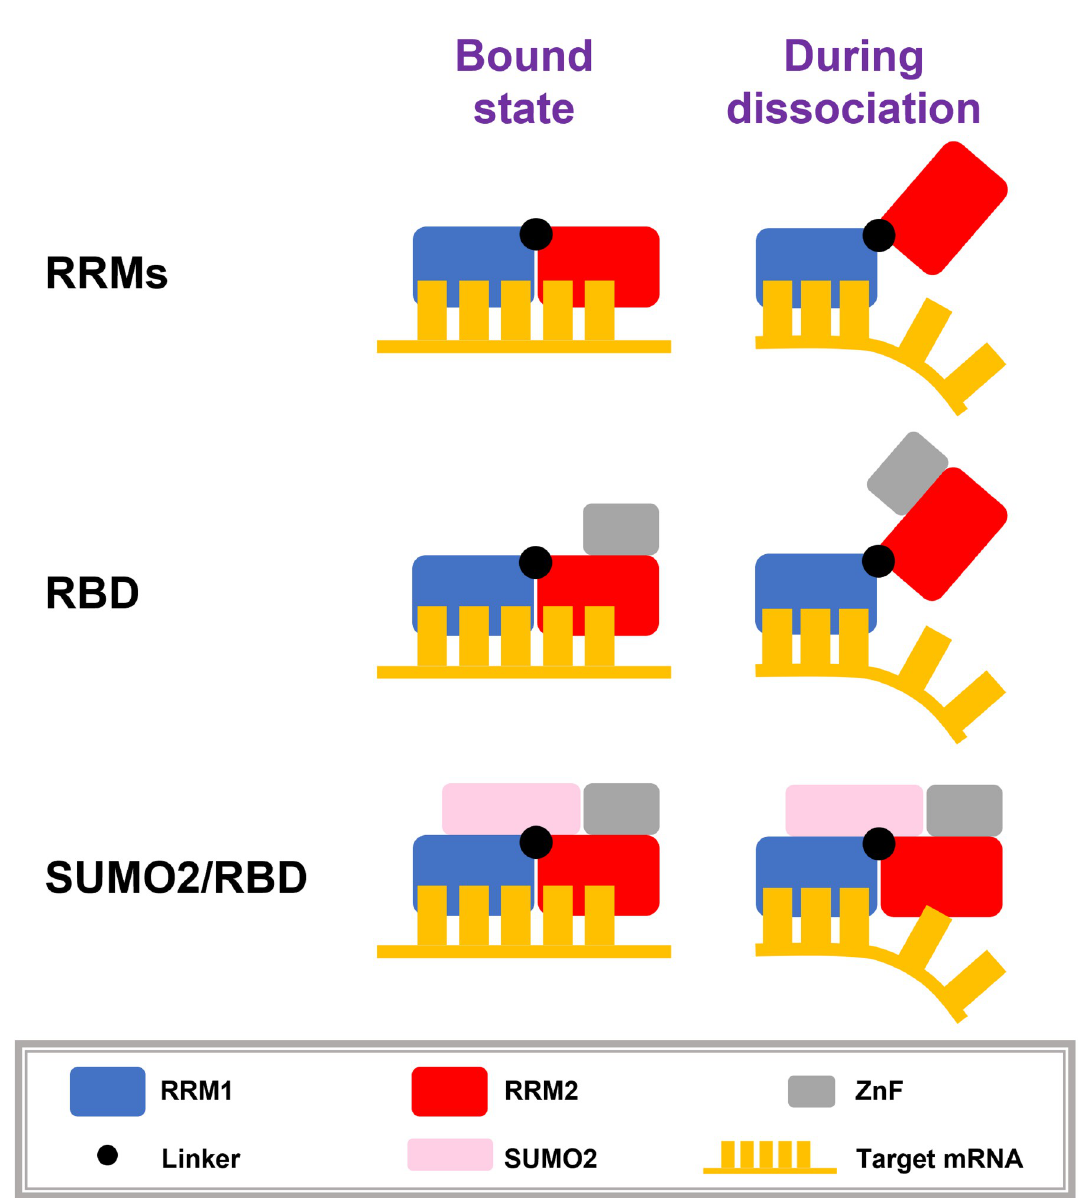
Fig 7. Schematic structural diagrams of the RNA dissociation processes from RRMs, RBD, and SUMO2/RBD. For the RRMs and the RBD, the RNA dissociation is a two-step process: RNA dissociation from RRM2 is followed by its dissociation from RRM1. For the SUMO2/RBD complex, RNA must dissociate from the two RRMs